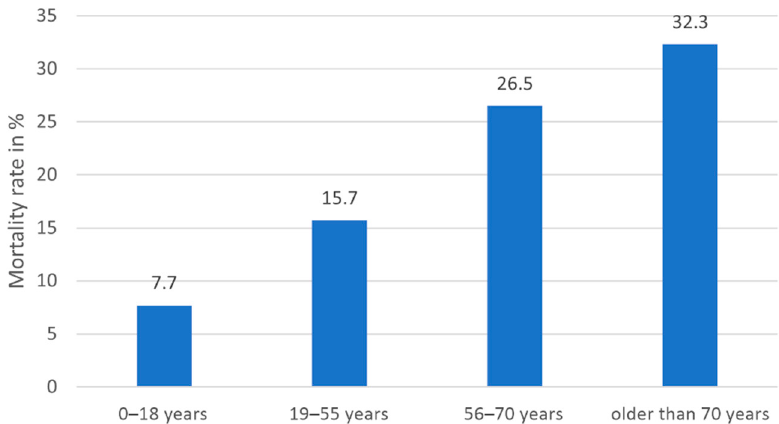
Figure 4. Overall mortality rates in percent per age group. Mortality rates increased with advancing age, whereby survival was worse in patients older than 70 years compared to patients aged 0–18 years ( p = 0.041) and 19–55 years ( p = 0.023). Data of three patients were missing. Patient sex. The overall mortality rate was 27.0% ( n = 74, 20 deaths) in women com- pared to 22.1% ( n = 104, 23 deaths) in men, 30-day mortality was 16.2% ( n = 74, 12 deaths) in women and 13.5% ( n = 104, 14 deaths) in men. These findings were, however, not sta- tistically significant (Pearson Chi-square p = 0.451 and p = 0.608, respectively).